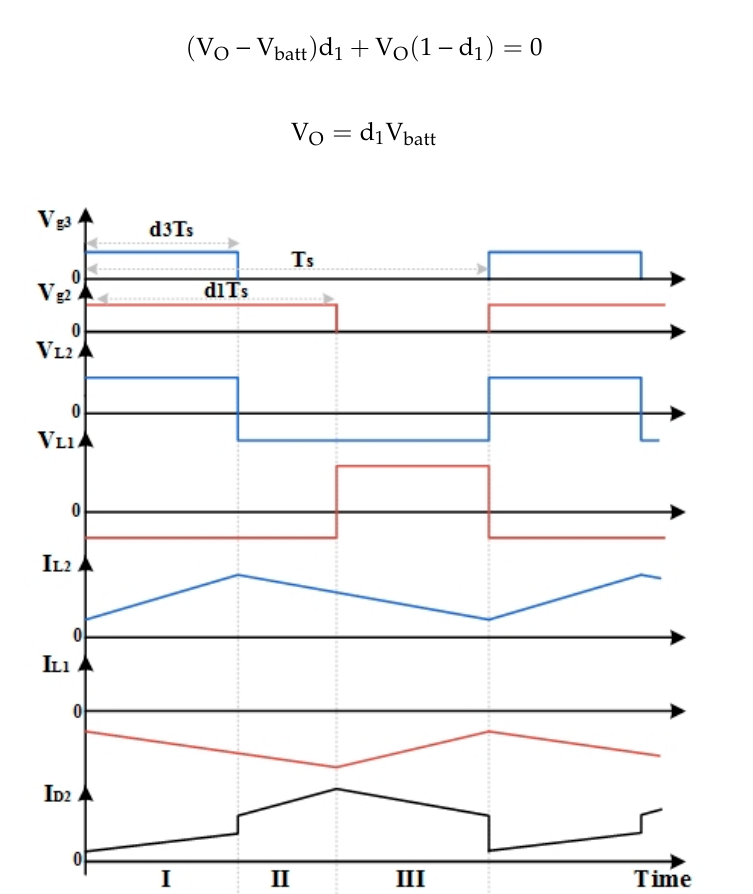
Figure 6. Current flow paths of operating stages in DISO mod: ( a ) Stage I; ( b ) Stage II; ( c ) Stage III.